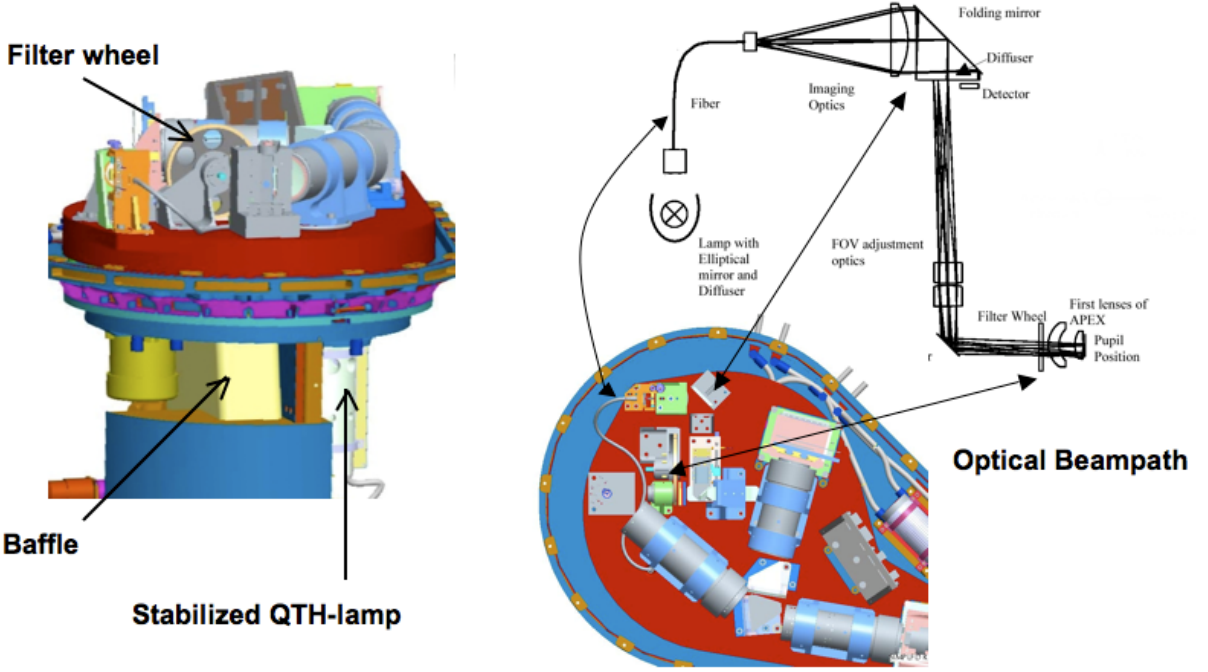
Figure 6. The In-Flight Calibration (IFC)